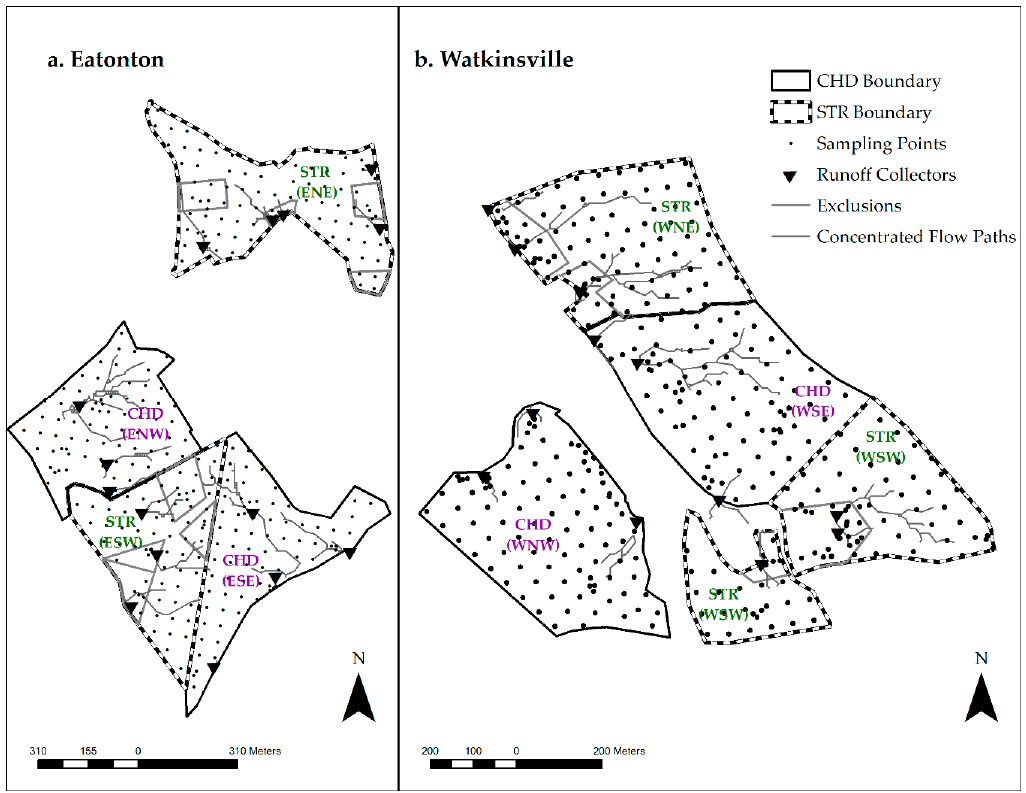
Figure 1. Maps showing; ( a ) Eatonton and ( b ) Watkinsville study sites with concentrated flow paths, pasture boundaries (CHD: continuous grazing with hay distribution, and STR: strategic grazing), runoff collectors, exclusions, and sampling locations (black dots).